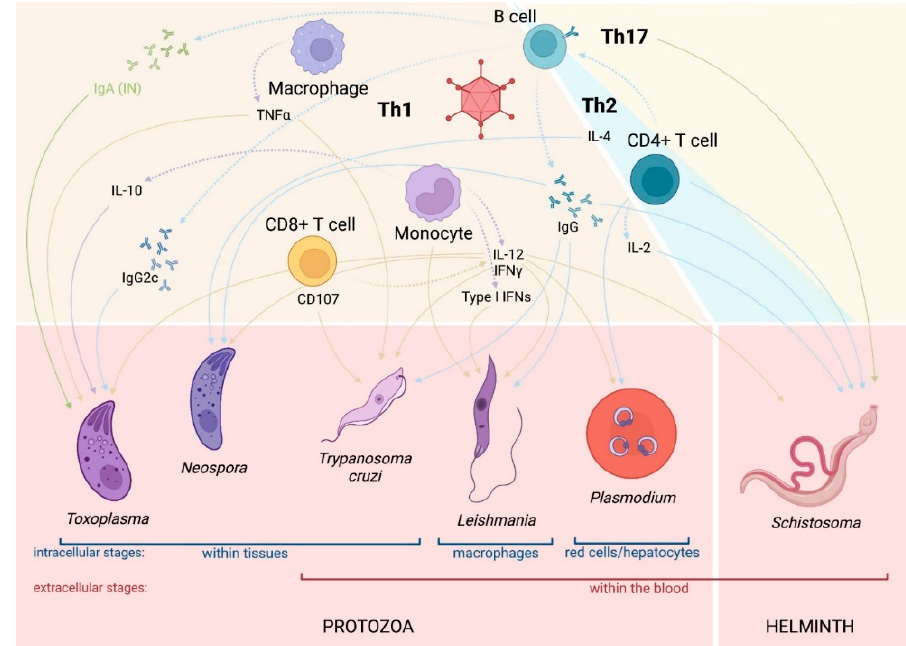
Figure 2. AdV vector immune effectors. The following is a graphical representation of the various immune effectors which have been shown by the papers herein to be activated by AdV vaccines. Included are hypothetical pathways (shown in dashed lines) contributing to cell-mediated and humoral immunity, which then target various protozoan and helminth parasites. Broadly, AdV vectors stimulate monocytes, macrophages, B cells, and CD4+ and CD8+ T cells within Th1-, Th2-, and Th-17 immunity (specific to Schistosoma AdV vaccines). These cells lead to the production of major immune effectors such as IL-12, IFN- γ , TNF- α , and antigen-specific IgG. Uniquely, AdV vaccines against T. gondii have shown associated production of IL-10, and when delivered intranasally (IN), they were also capable of eliciting antigen-specific IgA. Created with BioRender.com.